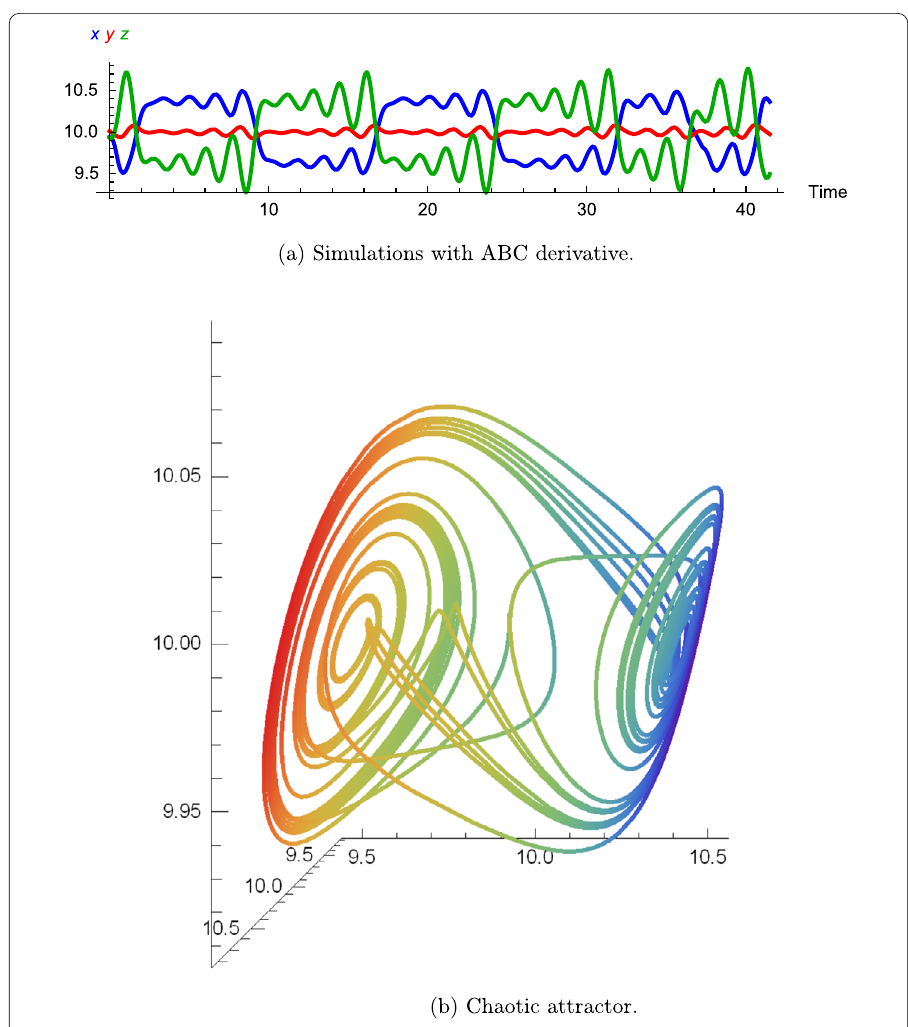
Figure 4 OPIM – ABC solutions of the modified Chua’s circuit in Example 4.1